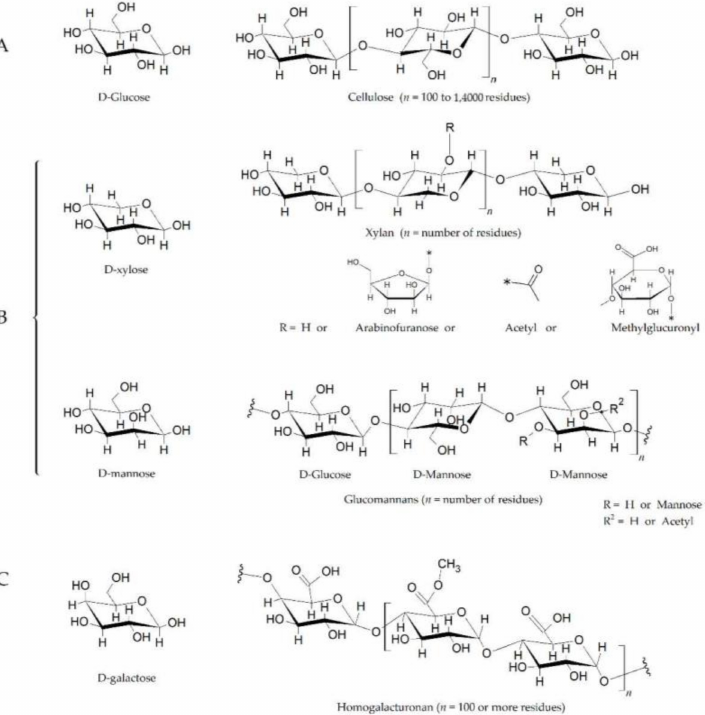
Figure 1. The plant cell wall is composed of polysaccharides such as cellulose, hemicellulose, and pectin. ( A ). Cellulose is a polymer of D -glucose units linked by β 1-4 bonds, also known as glucosidic bonds. ( B ). Xylans and glucomannans are two components of hemicellulose. The xylan backbone, which is composed of D -xylose linked together by β 1-4 bonds, also contains varying amounts of acetyl, methylglucuronyl, and arabinofuranosyl side chains. The arabinofuranosyl side chains can also be linked to aromatic acids (e.g., p-coumaric acid). Glucomannans are composed of D -glucose and D-mannose at a ratio of 1.6:1 (linked by β 1-4 bonds), and with branches of D -mannose residues at the C3 position ( β 1-3 bonds), on both glucose and mannose. ( C ). Pectin is the methylated ester of polygalacturonic acid, consisting of chains of 300 to 1000 galacturonic acid units joined with 1 α → 4 bonds. The structure shows three methyl ester forms ( − COOCH3) for every two carboxyl groups ( − COOH), having a 60% degree of esterification. The substituted residues at C-4 with neutral and acidic oligosaccharide side chain composing of arbinose, galactose, fructose, and glucuronic acid. The length of the chains and the attached residues and their placement varies among plant species